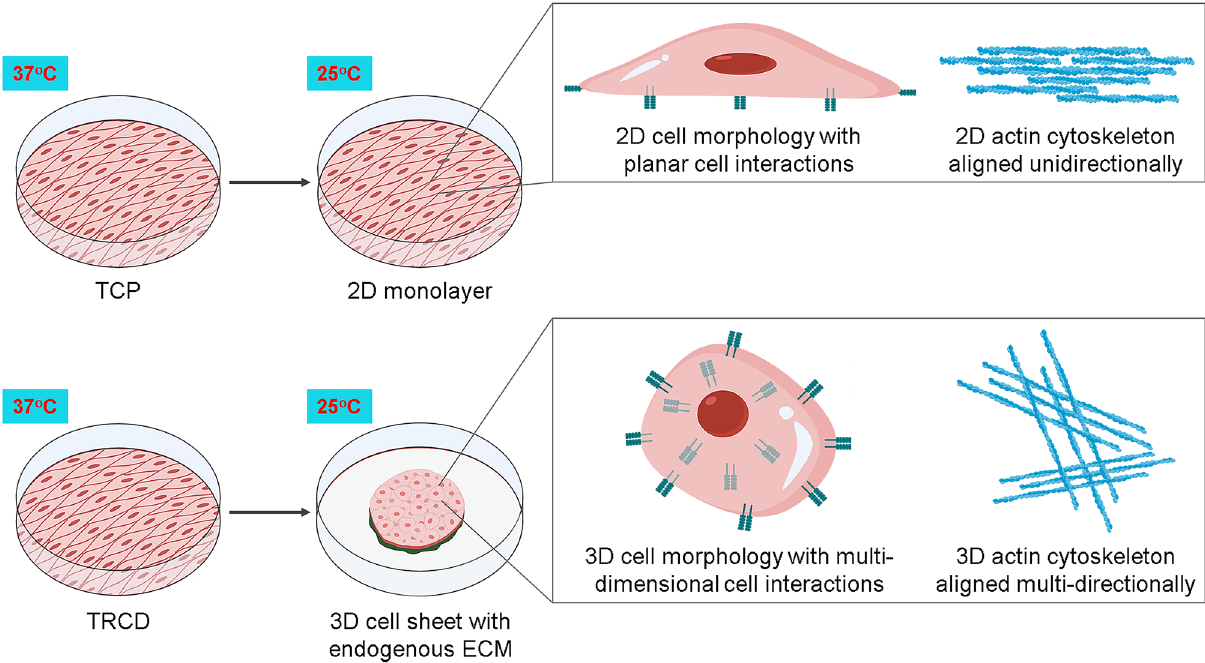
Figure 6. MSC sheet 3D structural and molecular transition. A schematic representation of TRCD- cultured MSC sheet temperature detachment and sheet contraction resulting in a tissue-like 3D system. 2D–3D transition prompts dynamic cell morphology and actin cytoskeleton changes with increased cell–cell interactions. These features of 3D MSC sheet culture and production augment MSC paracrine-relevant secretory capacity. Created with